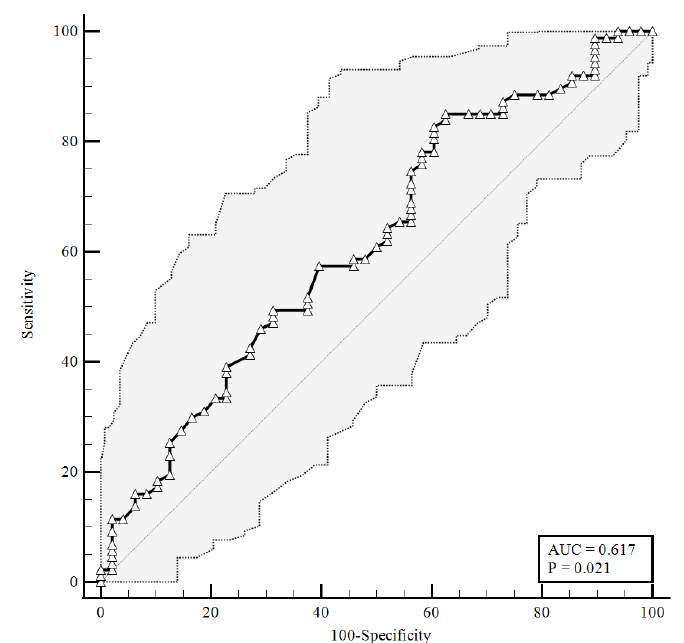
Figure 2. ROC curve for plasma CGRP levels at the time of hospital admission predicting a faster clinical recovery (85.06% sensitivity, 37.5% specificity). AUC = area under the curve, p = p -value.